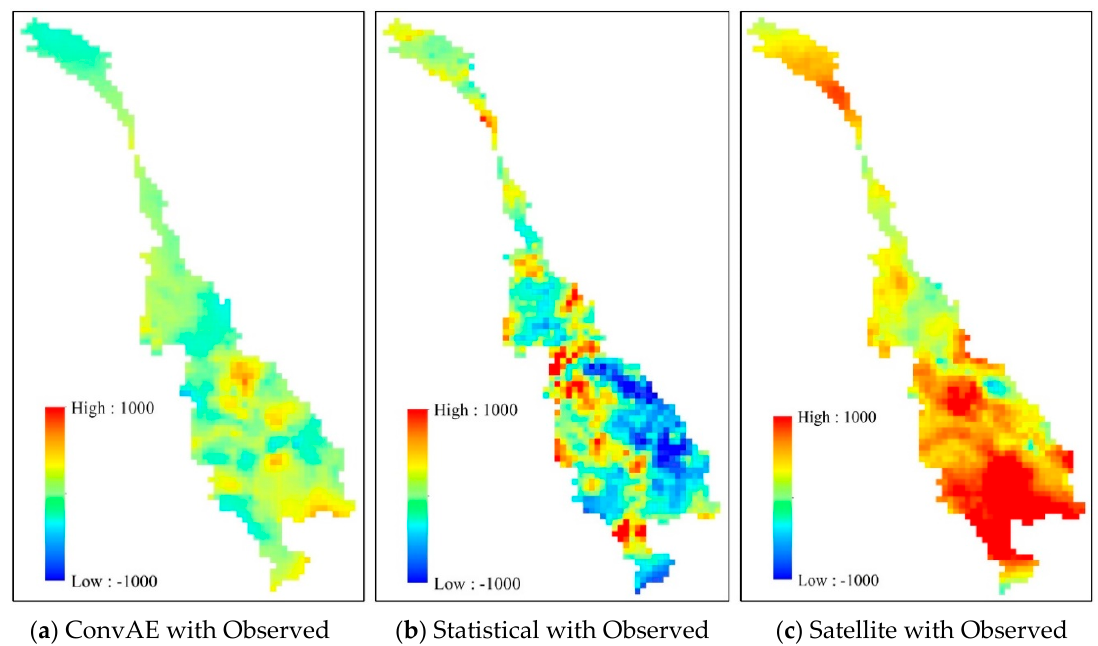
Figure 15. Spatial bias distribution pattern of the precipitation products compared to the observed data in 2014.